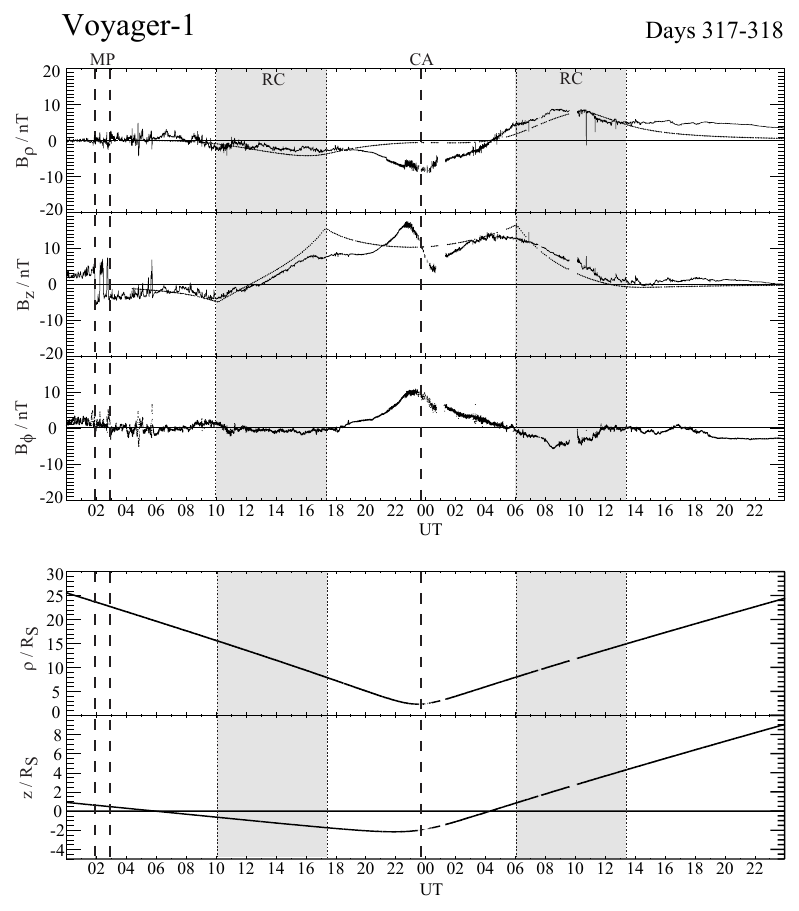
Fig. 3. Plot showing magnetic field and position data for the Voyager-1 fly-by of Saturn. Data for two (Earth) days are shown, corresponding to days 317 and 318 of 1980. The top three panels show the residual field components in cylindrical coordinates referenced to the planet’s spin (and magnetic) axis, namely from the top downwards, B ρ , B z , and B ϕ (in nT). These residuals are the measured field minus the SPV model of the internal planetary field (which is zero in the case of the azimuthal component). The dotted lines show the components of the ring current field model derived by Connerney et al. (1983) (which again has zero azimuthal component). The model parameters (see Eq. (1)) are R 1 = 8 R S , R 2 = 15 . 5 R S , D = 3 R S , and µ 0 I 0 ≈ 60 . 4nT. The lower two panels show the position of the spacecraft, namely the cylindrical radial distance from the planet’s spin (and magnetic axis), ρ , and the distance along this axis from the equatorial plane, z . The left-hand vertical dashed lines marked “MP” show the positions of the first and last of five inbound magnetopause transitions (at spherical radial distances between 23 and 24 R S ), while the central vertical dashed line marked “CA” shows the closest approach of the spacecraft to the planet (at a spherical radial distance of 3.1 R S ). The vertical dotted lines indicate the intervals during which the spacecraft lay within the cylindrical radial range of the current sheet, that is within 8 ≤ ρ ≤ 15 . 5 R S (marked